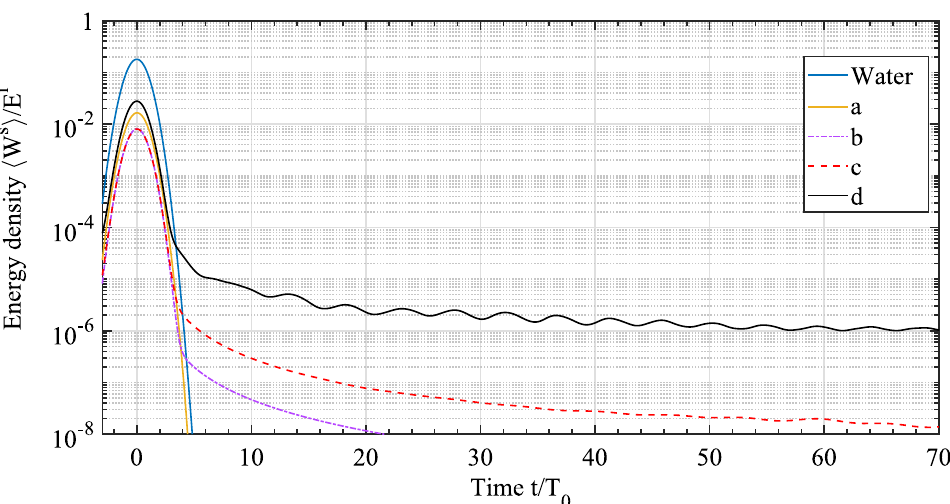
W s (plots are normalized by the total incident (cid:31) (cid:30) 0.1 =